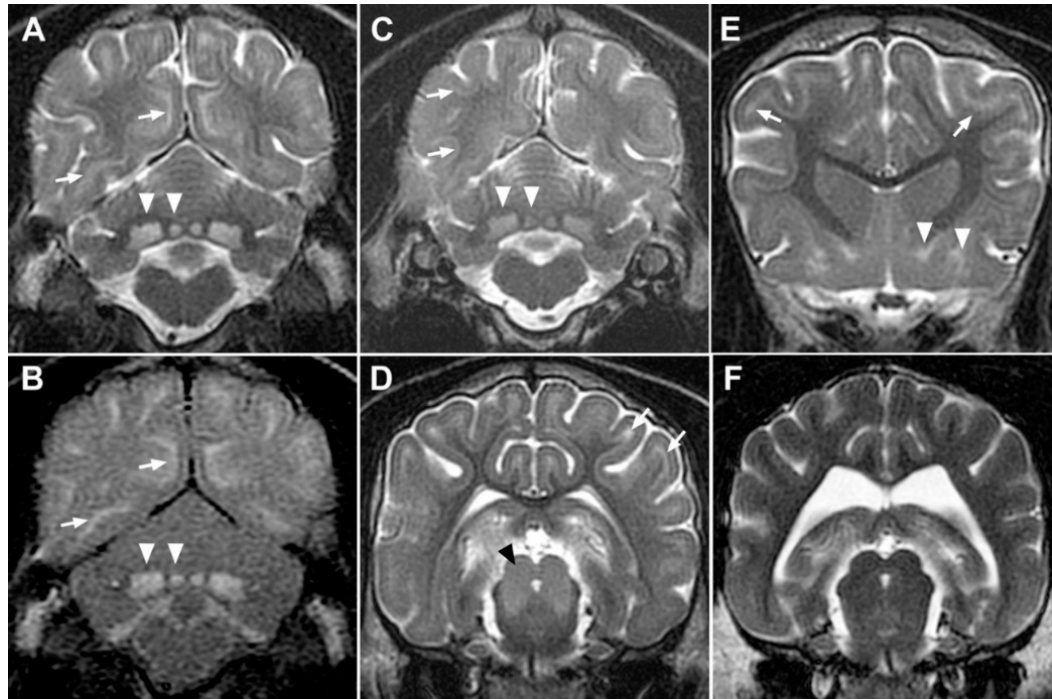
Figure 2. MRI abnormalities in SSADHD-affected Saluki Dogs . Transverse T2-weighted ( A , C – F ) and FLAIR ( B ) MR images at the level of the cerebellum ( A – C ), midbrain ( D , F ) and corpus striatum ( E ) demonstrating symmetrical involvement of predominantly grey matter structures. Images from dog 1 ( A , B , D , E ), dog 2 ( C ) and an unaffected littermate ( F ). Consistent bilateral symmetrical T2 hyperintensity of the deep cerebellar nuclei (( A – C ); white arrowheads) is the most prominent finding. Similar bilaterally symmetrical hyperintensity is seen involving the tectum and dorsal tegmentum (( D ); black arrowhead) and endopeduncular (medial) and lentiform nuclei (( E ); white arrowheads) but not present in unaffected dog images ( F ). Sulci are prominent ( D ) compared to an unaffected age matched control ( F ), consistent with atrophy of cortical grey matter. Hyperintensity of deep cortical grey mater laminae is evident on T2-weighted and FLAIR images at all levels (white arrows) is not present on unaffected dog MR images ( F ).